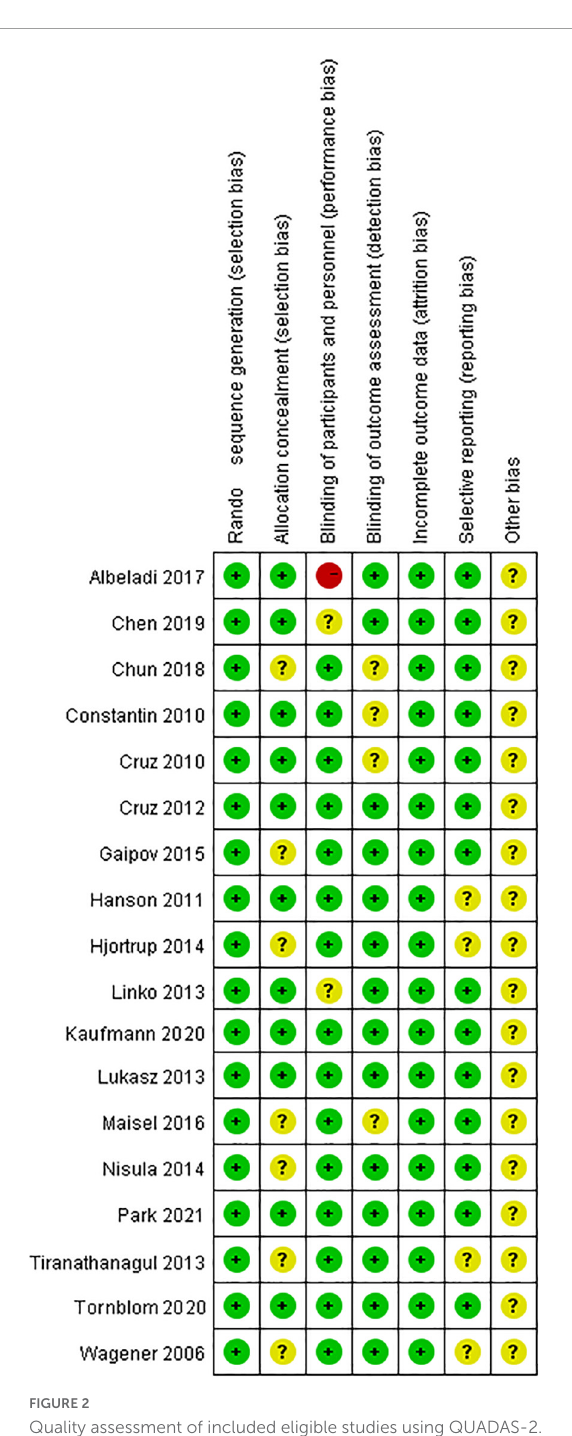
FIGURE2 Quality assessment of included eligible studies using QUADAS-2.